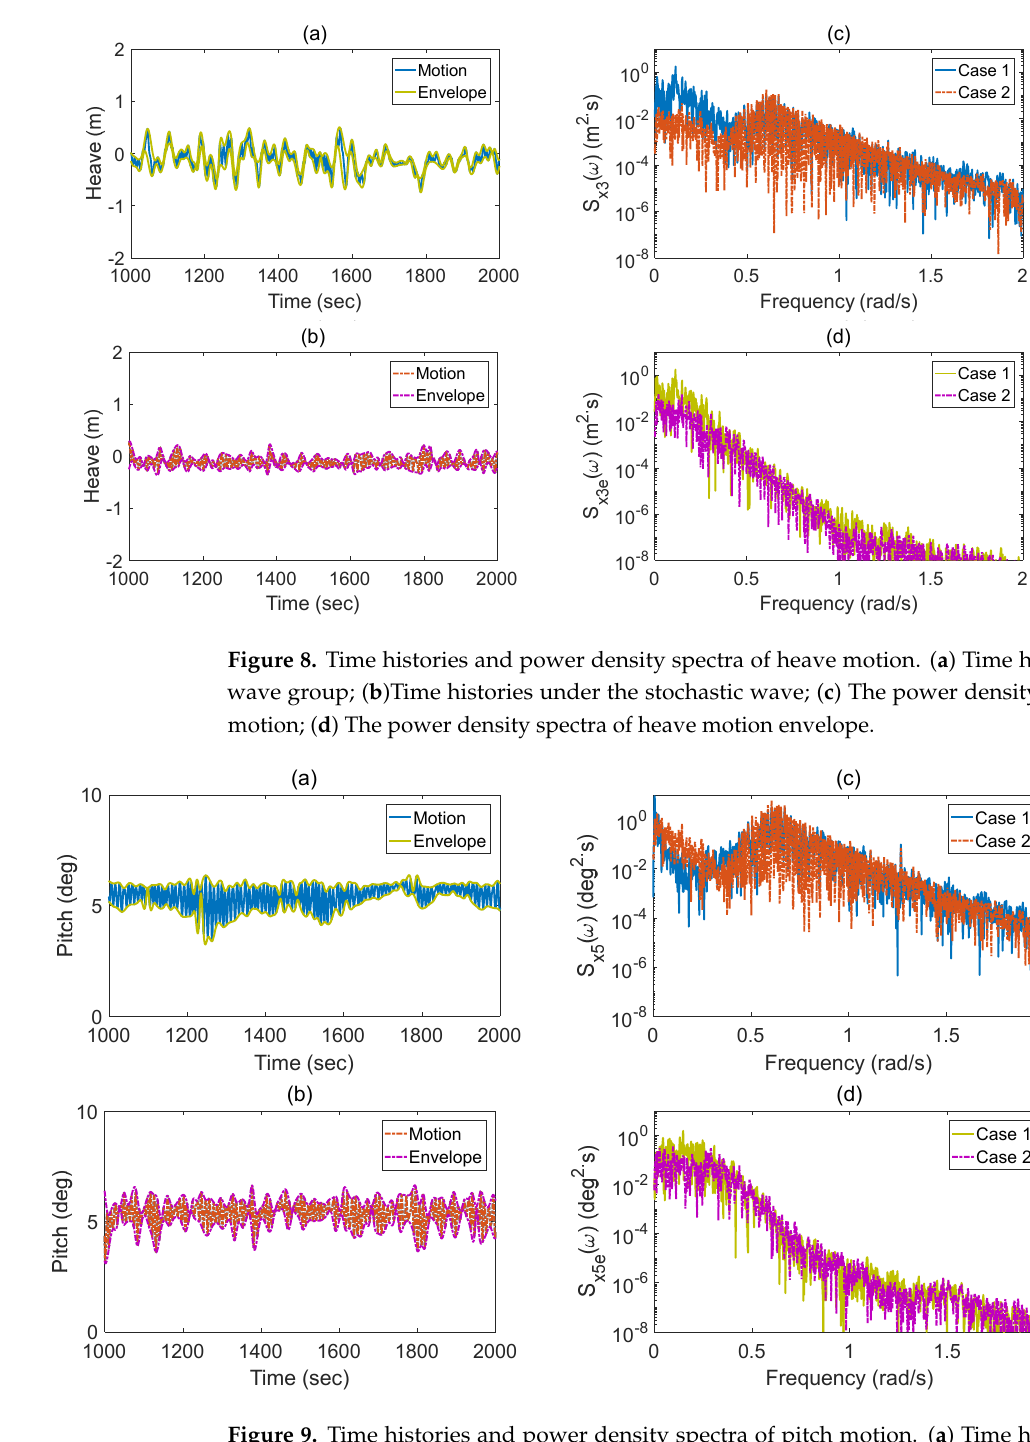
Figure 10. Time histories and power density spectra of thrust and power. ( a ) Time histories of thrust; ( b ) The power density spectra of thrust; ( c ) Time histories of power; ( d ) The power density spectra of power.